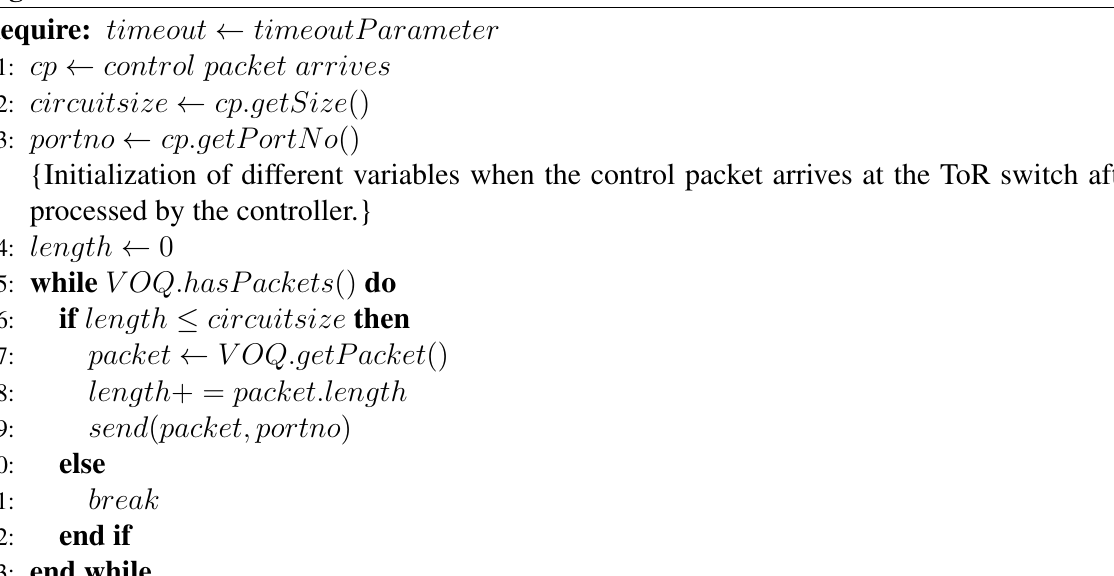
Algorithm 2 Circuit Transmission at ToR